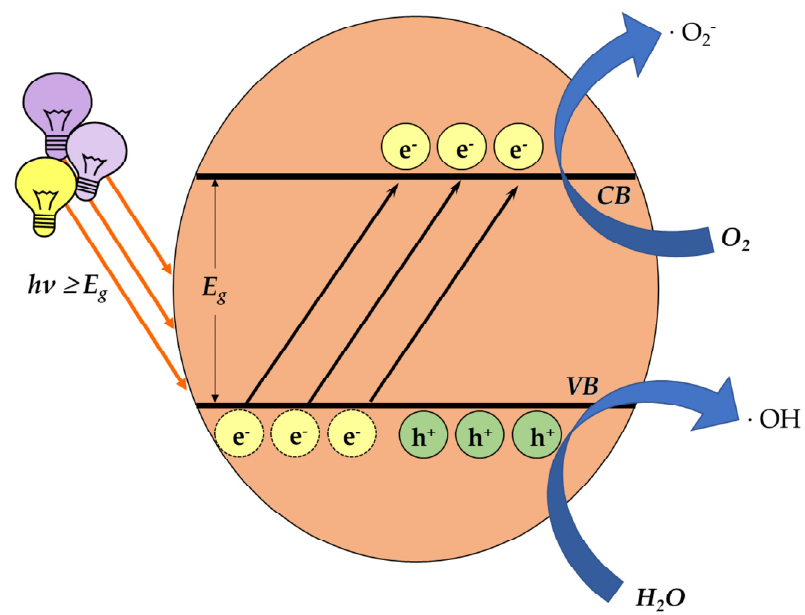
Figure 4. The process of ROS generation through photocatalysis. When light energy is transferred on the surface of a photocatalyst, the excited electrons move from the valence band to the conductivity band, creating positive holes in the valence band. The generated charges, reacting with water (H 2 O) and O 2 molecules around them, form